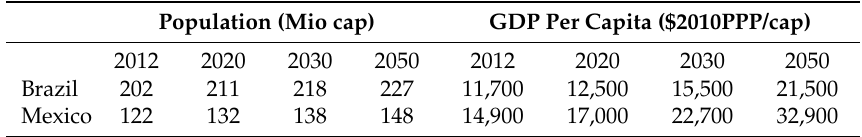
Table 1. Projections of population and economic growth in Brazil and